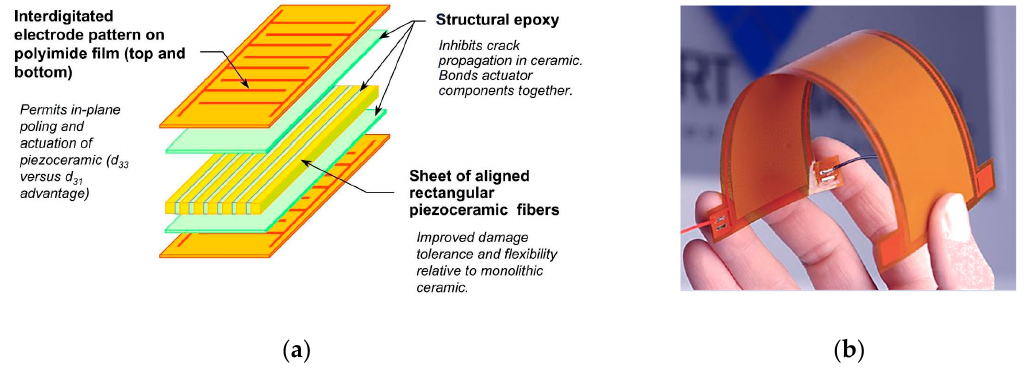
Figure 1. Macro-fiber composite (MFC) piezoelectric devices [27]: ( a ) structural arrangement; ( b ) patch layout.